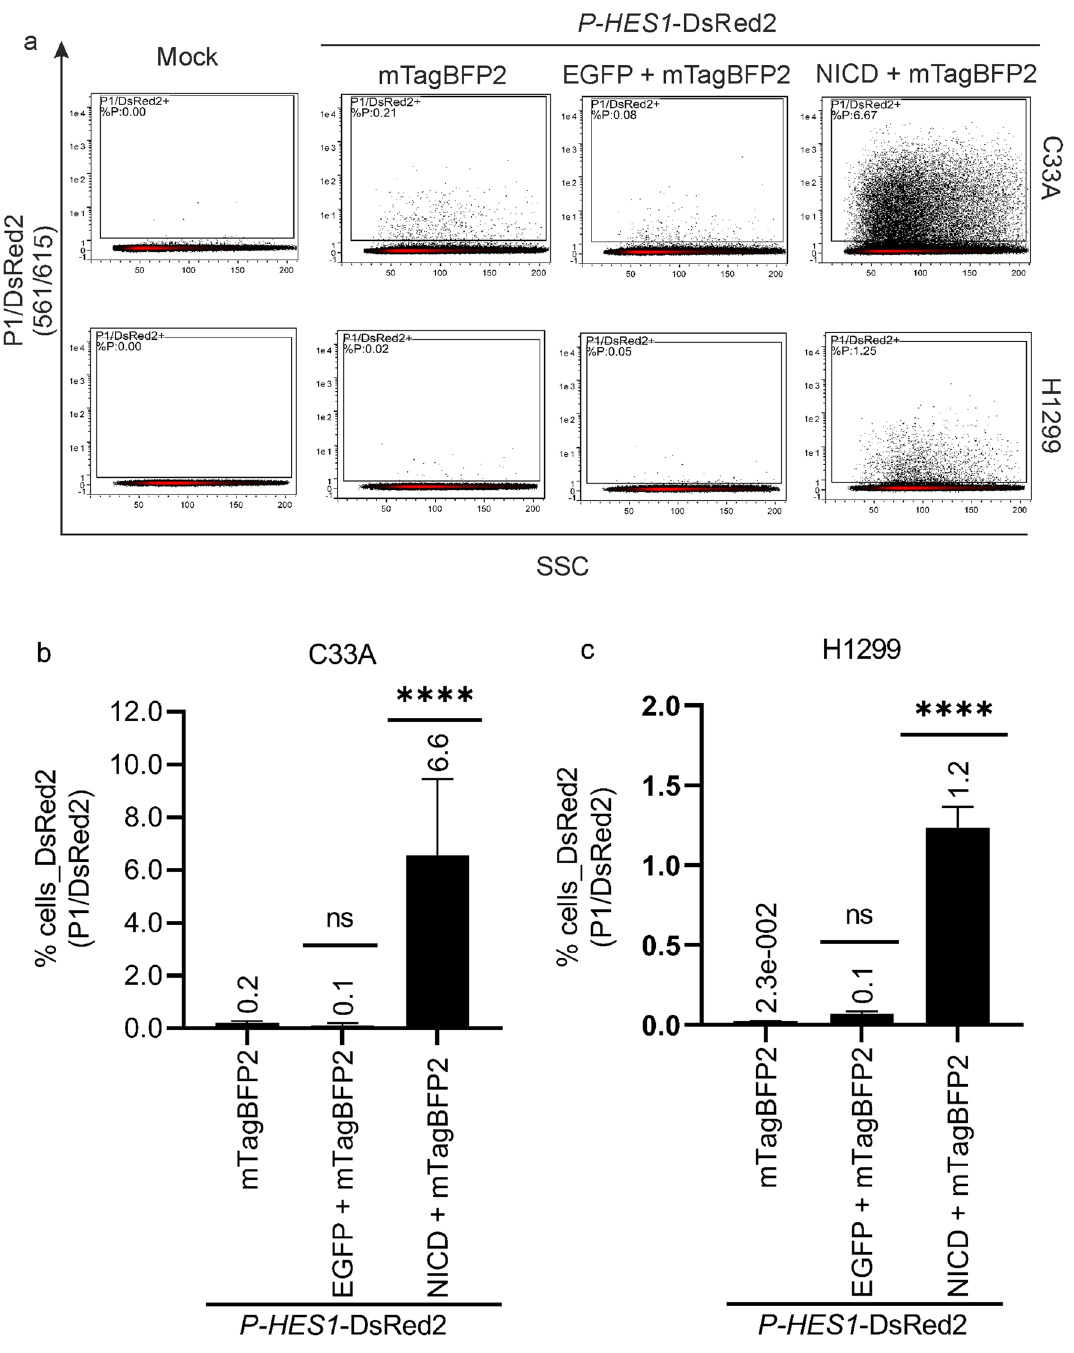
Figure 4. Notch activation by exogenous NICD. C33A and H1299 cells were co-transfected with 250 ng P-HES1 - DsRed2 reporter plasmid, 250 ng EGFP or 250 ng NICD activator plasmid and 125 ng mTagBFP2 plasmid as indicated. C33A and H1299 cells were harvested for FACS measurement 48 h or 36 h post transfections, respectively. Living cells (P1) were gated for DsRed2 signal reporting the Notch pathway activity. ( a ) . Representative FACS plots show that the endogenous NICD is unable to activate the expression of the Notch target HES1 gene (Column2 and Column3) sufficiently. Upon co-transfection of NICD (Column4), the increased cell population of DsRed2 positive cells clearly indicates the exogenous activation of Notch signaling. ( b, c ) . Three independent biological replicates were conducted. A significant cell population of DsRed2 positive cells was detected in C33A (b) and H1299 (c), respectively in presence of exogenous NICD ( P-HES1 -DsRed2 + mTagBFP2 + NICD). In contrast, the endogenous NICD does not activate P-HES1 -DsRed2 expression sufficiently ( P-HES1 -DsRed2 + mTagBFP2), independent of the co-transfection of EGFP control plasmid ( P-HES1 -DsRed2 + mTagBFP2 + EGFP). The mean % cells of DsRed2 expressing cell populations as gated for each sample is stated above each bar and the error bars plotted indicate the standard deviation of the mean from the three independent biological replicates. P-values were calculated using One-Way ANOVA with Fischer’s LSD test by comparing the mean of each sample with mean of P-HES1 -DsRed2 + mTagBFP2. **** = P ≤ 0.0001, ns = P >